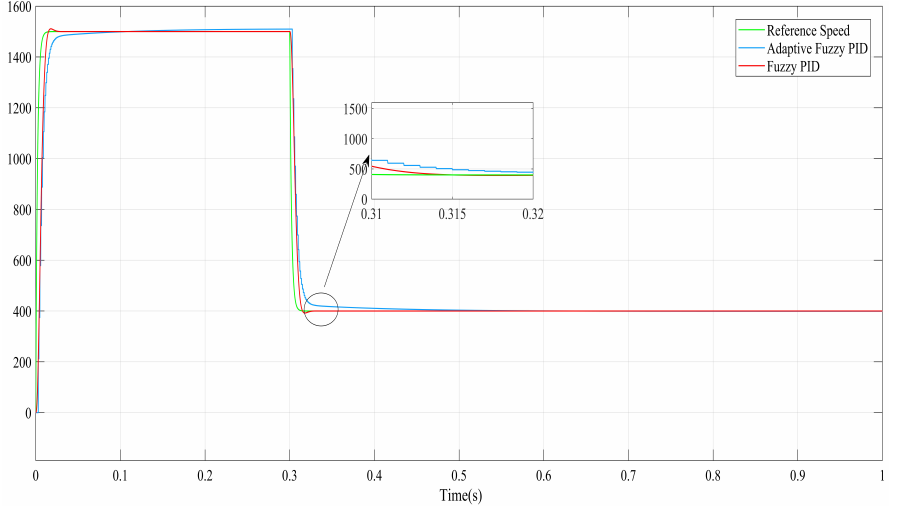
Figure 12. Measured speed response to step change with speed reference when speed